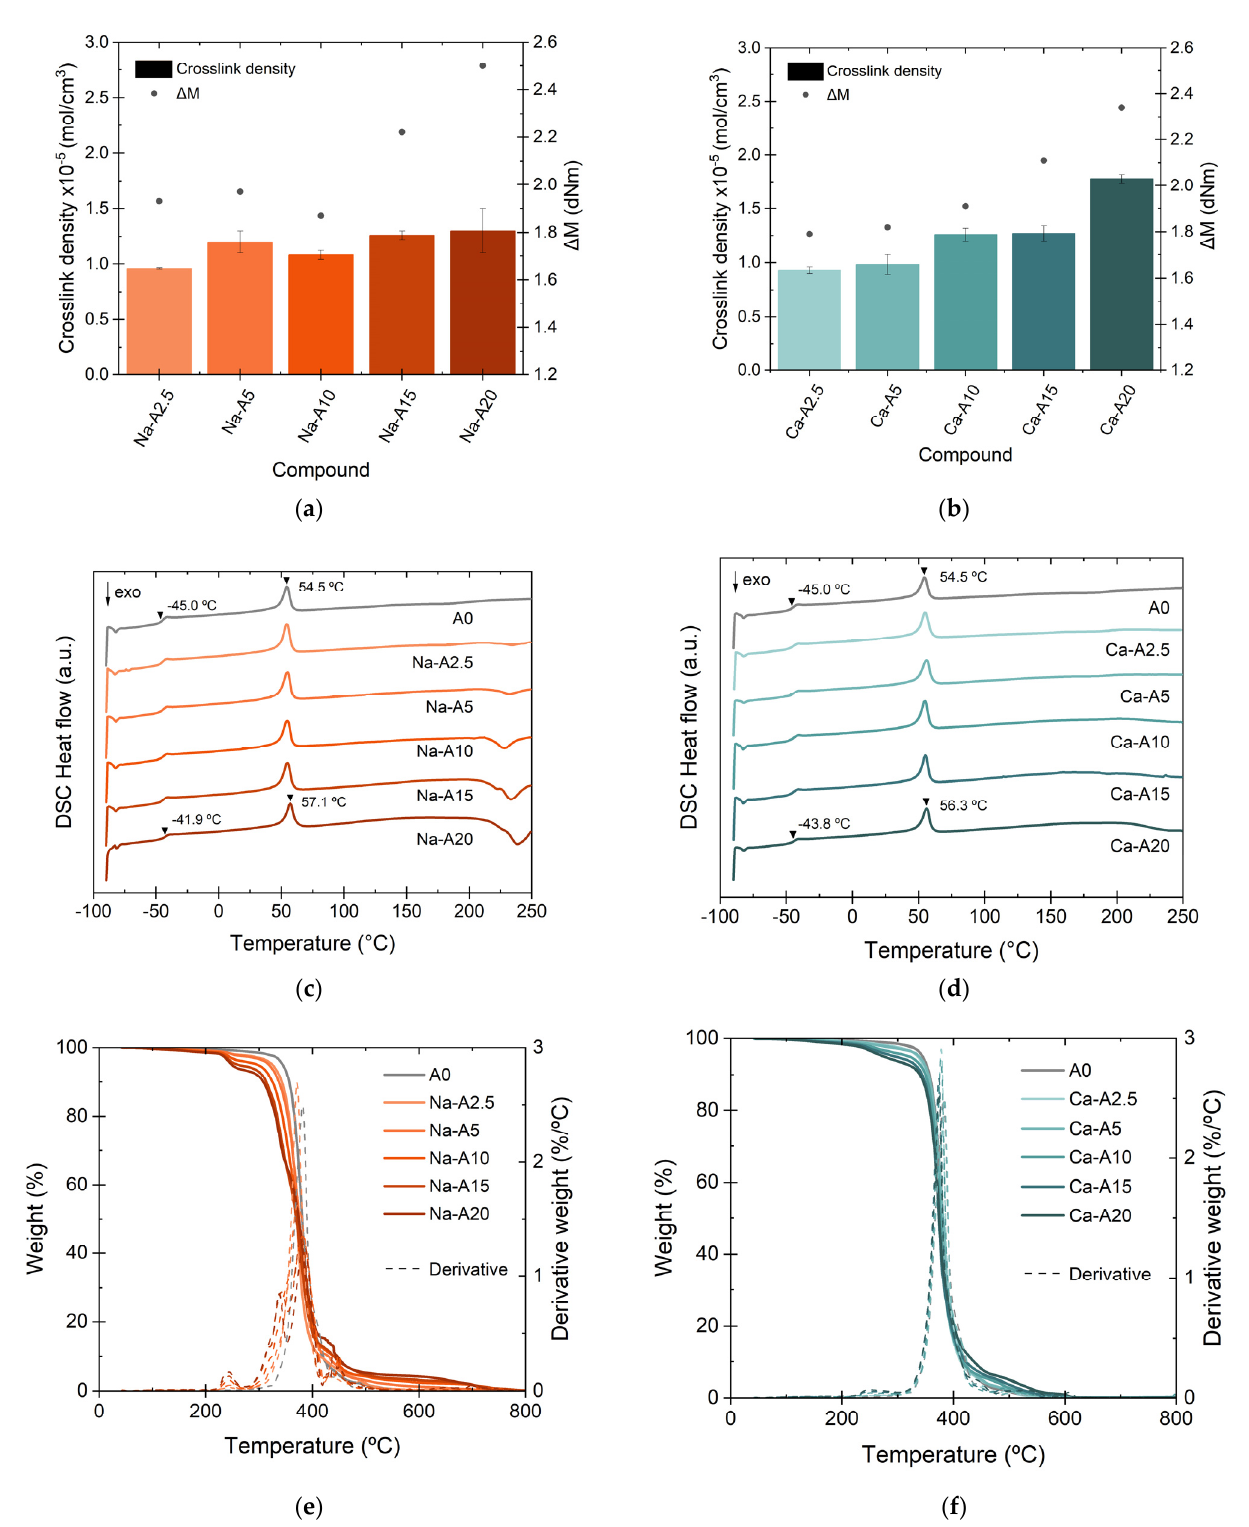
Figure 10. ( a , b ) Relation between crosslink density and torques, ( c , d ) DSC thermograms, and ( e , f ) thermogravimetric curves of Na-A- and Ca-A-reinforced TPEs, respectively.